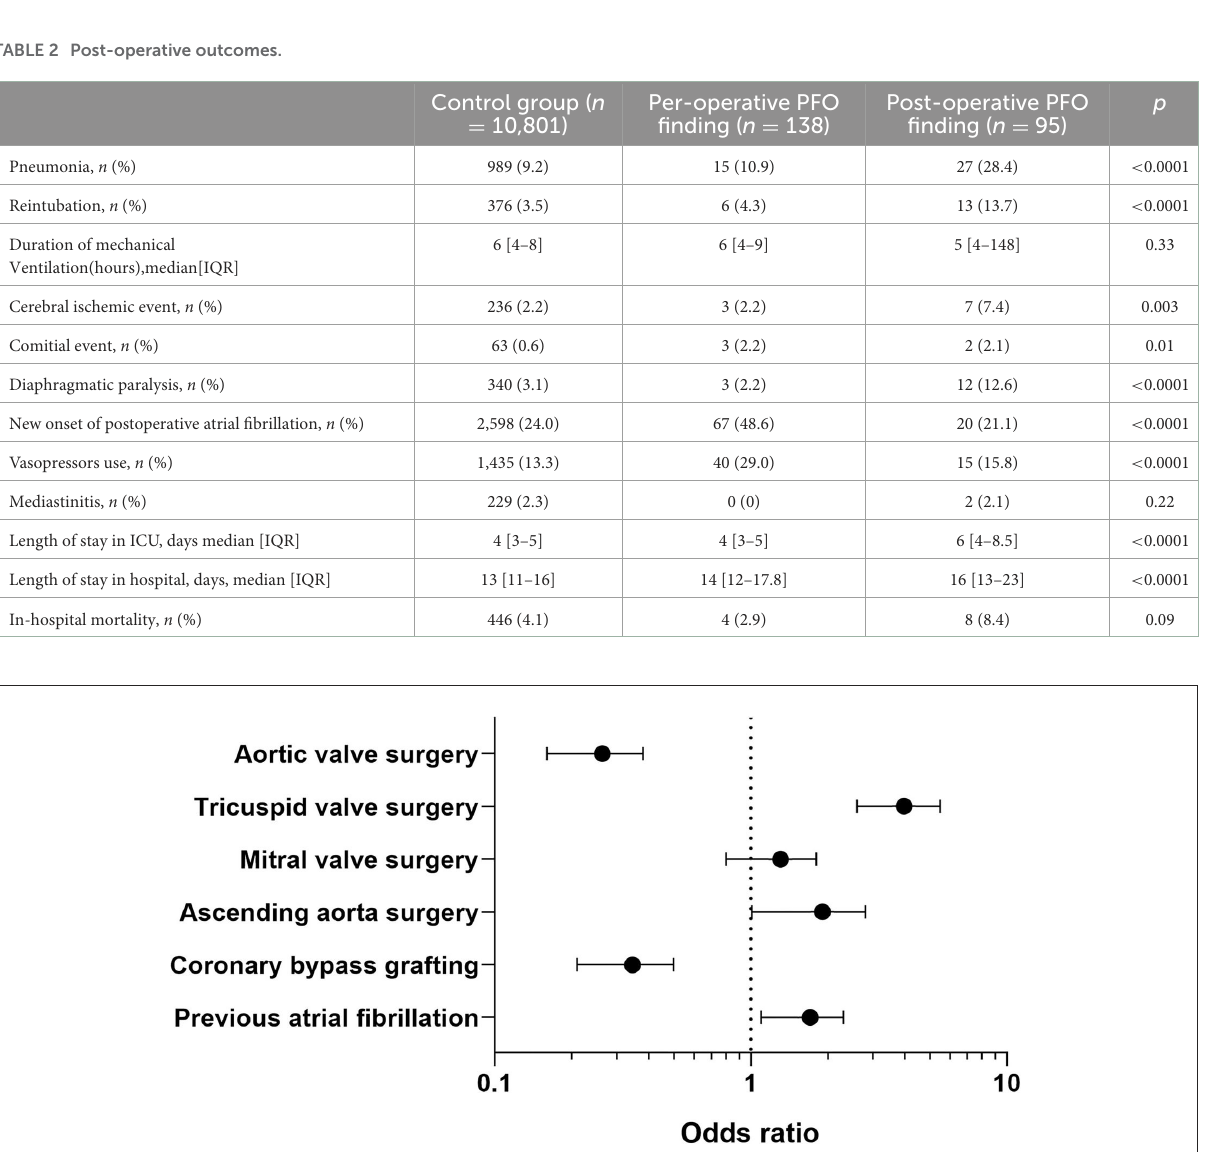
TABLE 2 Post-operative outcomes.